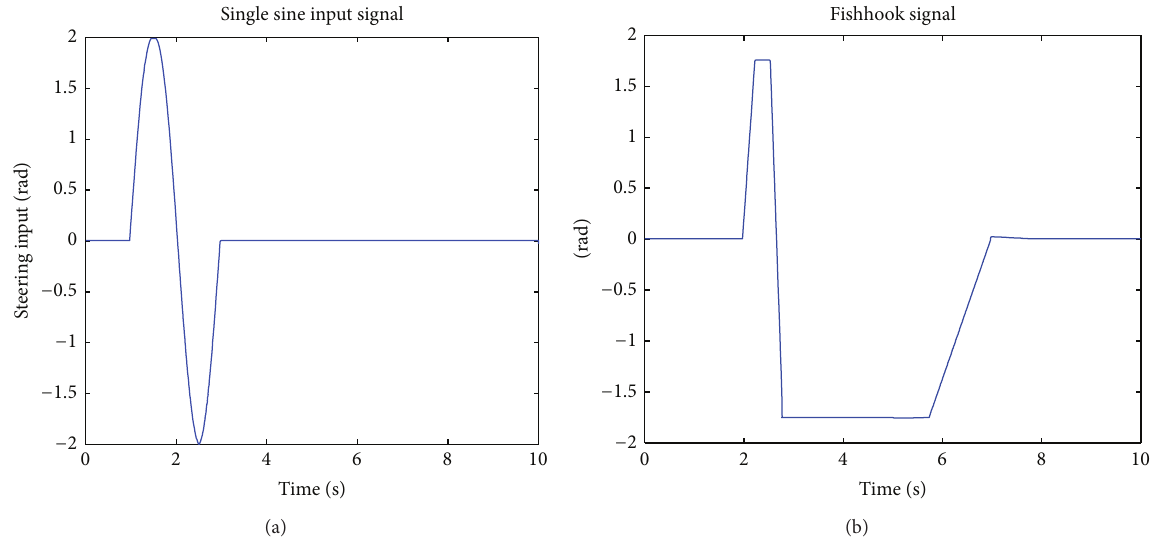
Figure 6: (a) Single sine input signal and (b) fishhook signal.